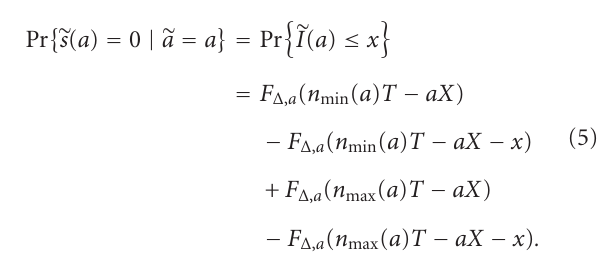
the next wake-up is zero. Therefore the probability that the sleep duration is